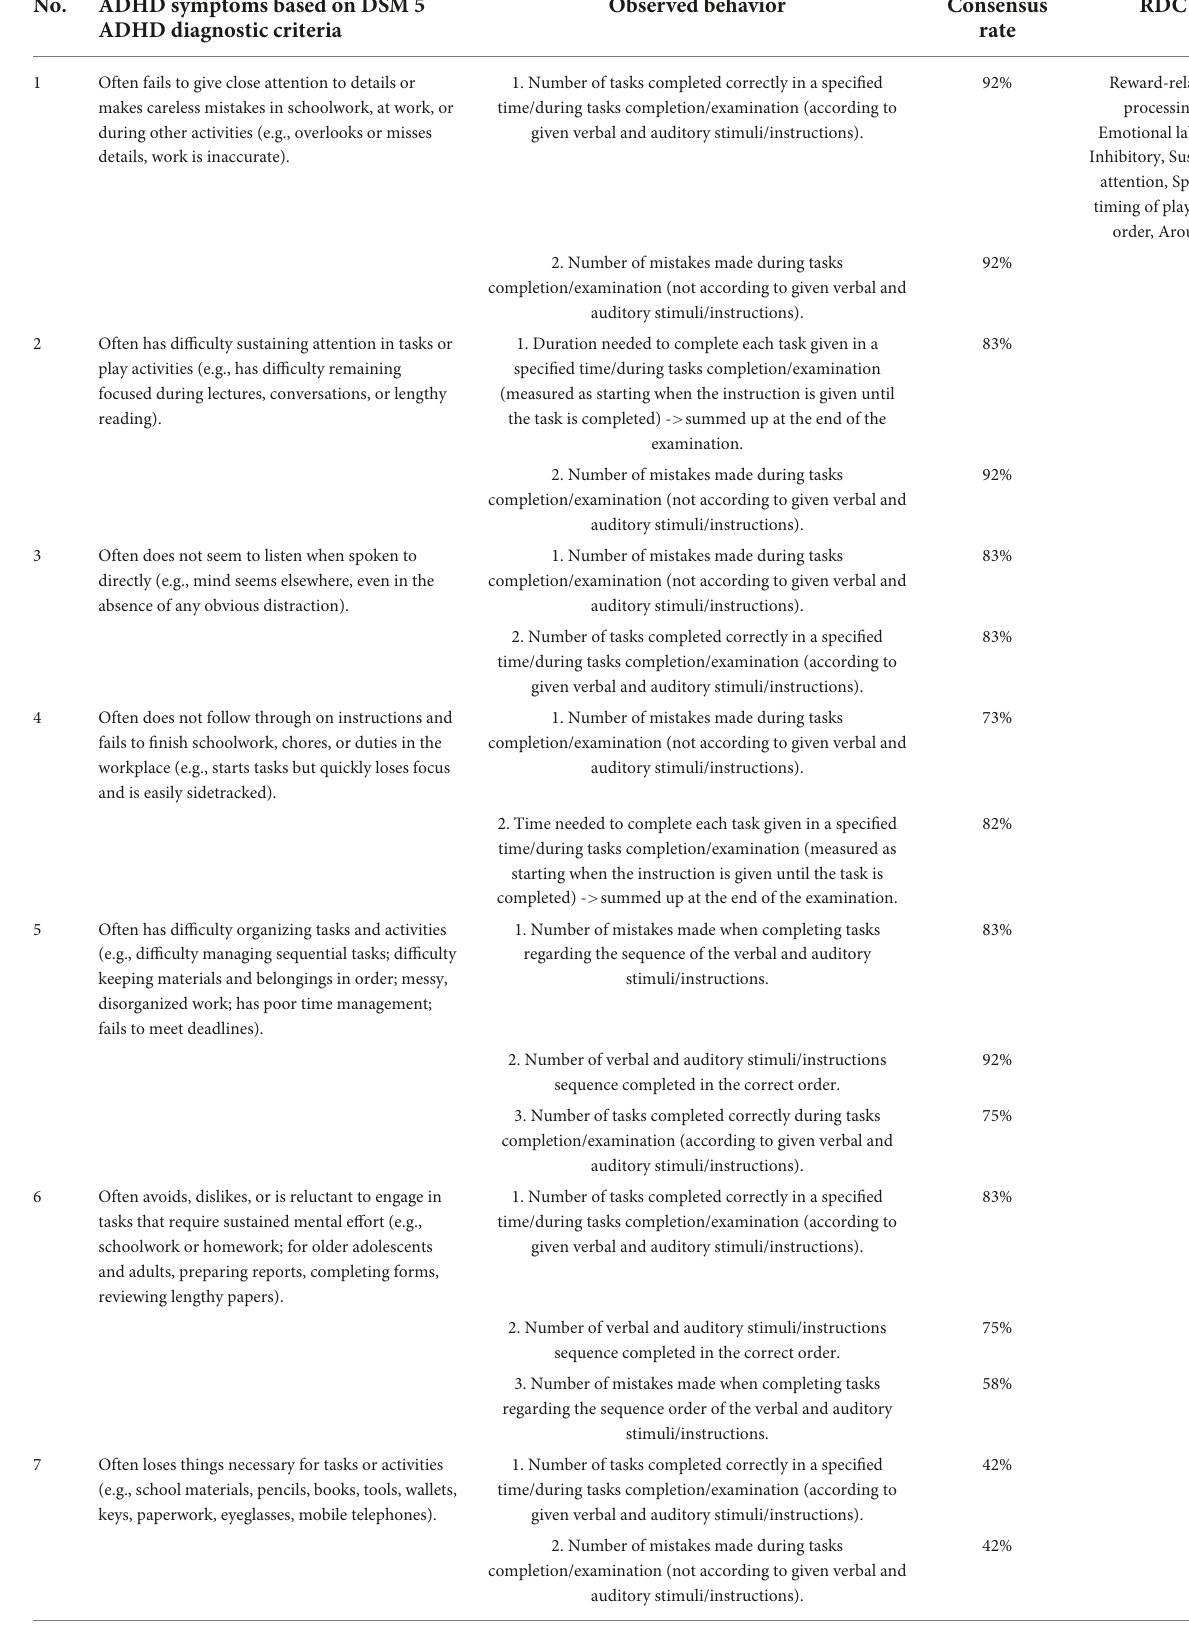
TABLE 1 Expert consensus on attention deficits/hyperactivity disorder (ADHD) classroom behavior based on DSM-5 and RDC. No. ADHD symptoms based on DSM 5 ADHD diagnostic